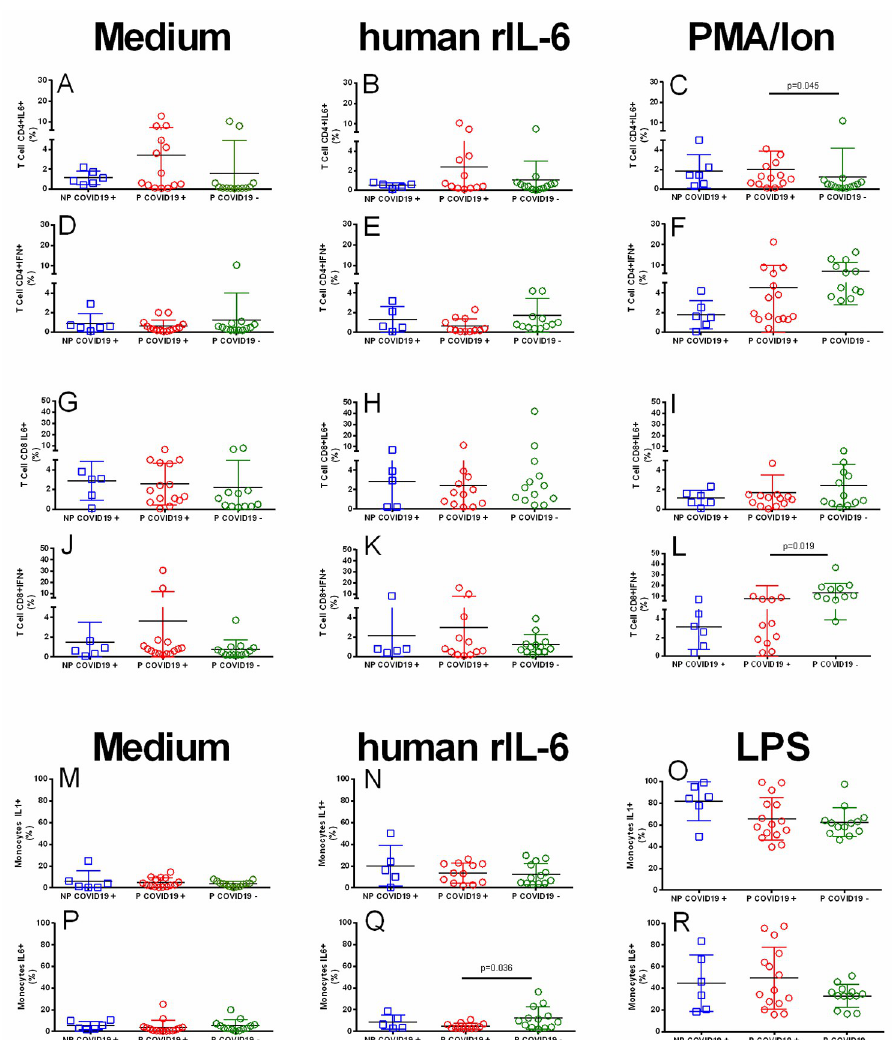
Fig 2. Percentage of cytokine-positive leucocytes. Whole blood cells were immunophenotyped as described in the methods. The results are expressed as the mean ± SD. Significance value was p < 0.05. Kruskal–Wallis and Dunn’s multiple comparisons tests were calculated. Non-Pregnant COVID-19 positive (NP-COVID-19+, n = 5–6). Pregnant COVID-19 positive (P-COVID-19+, n = 12–15). Pregnant COVID-19 negative (P-COVID-19-, n = 12–13).